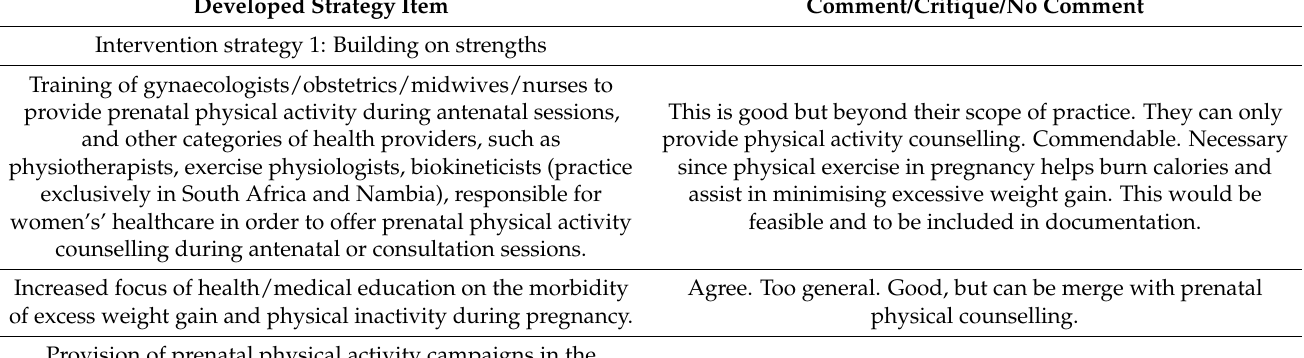
Table 2. Experts analyses and comments on the developed prenatal physical activity strategy. Developed Strategy